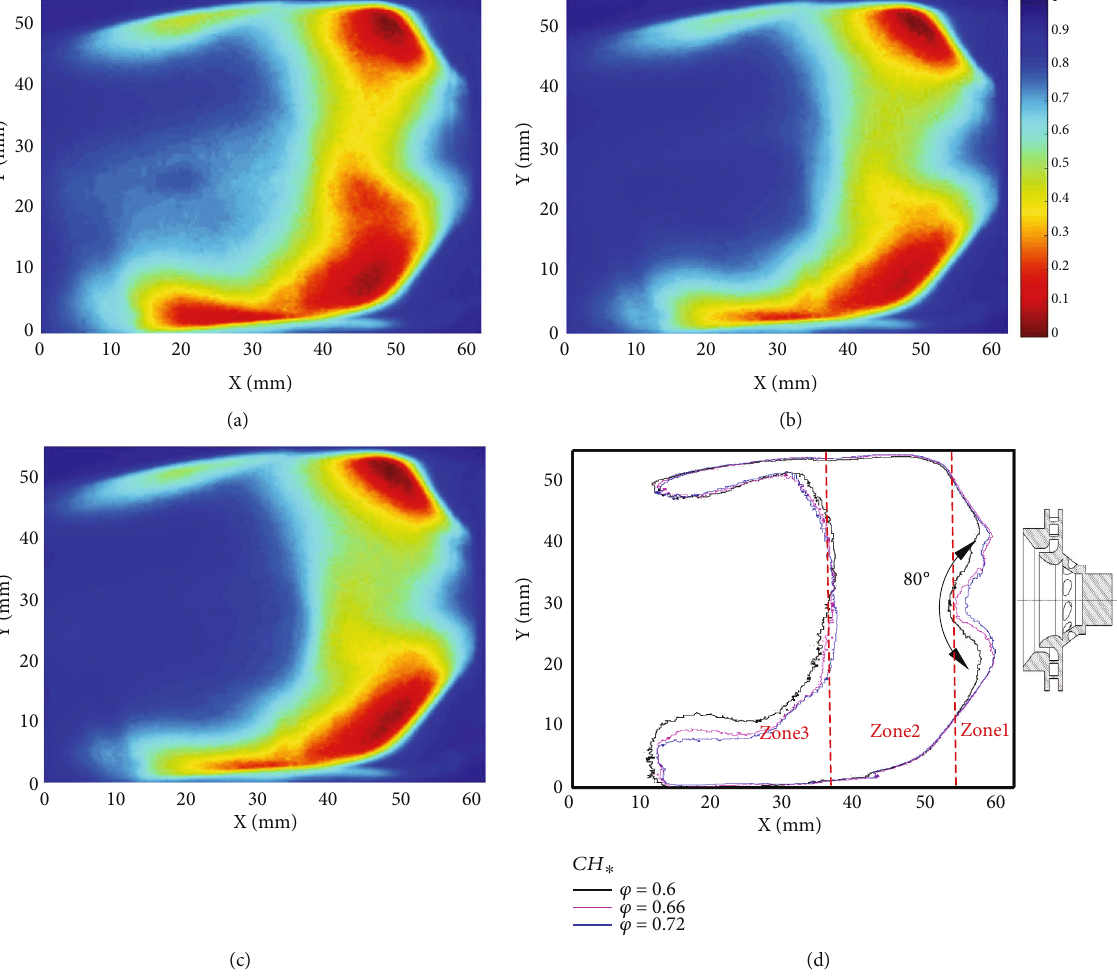
Figure 10: Distributions of CH ∗ chemiluminescence image: (a) φ =0.6, (b) φ =0.66, (c) φ =0.72, and (d) boundaries of CH ∗ chemiluminescence